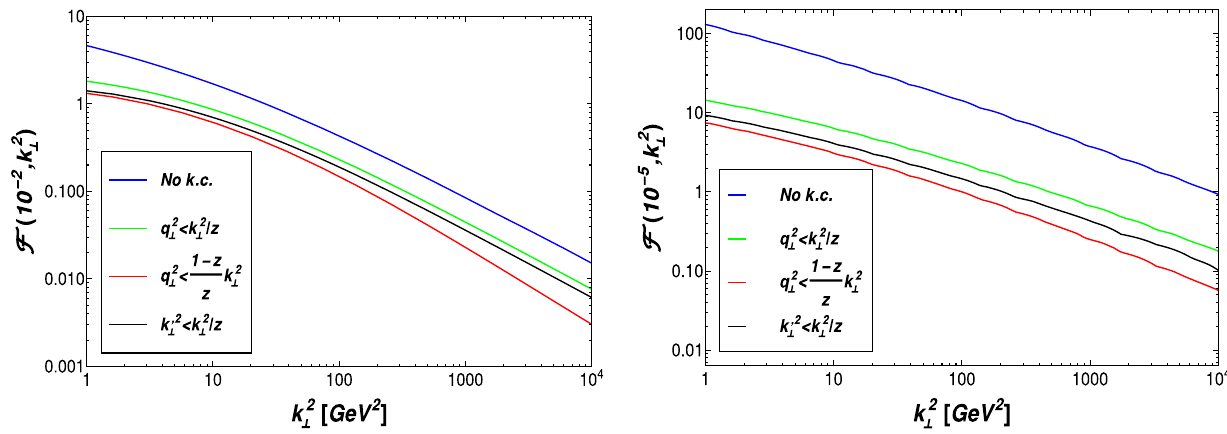
Fig. 4 Solutions of the BFKL equations with different forms of the kinematical constraint as functions of k T for constant ¯ α S = 0 . 2. Left plot: x = 10 − 2 , right plot: x = 10 − 5